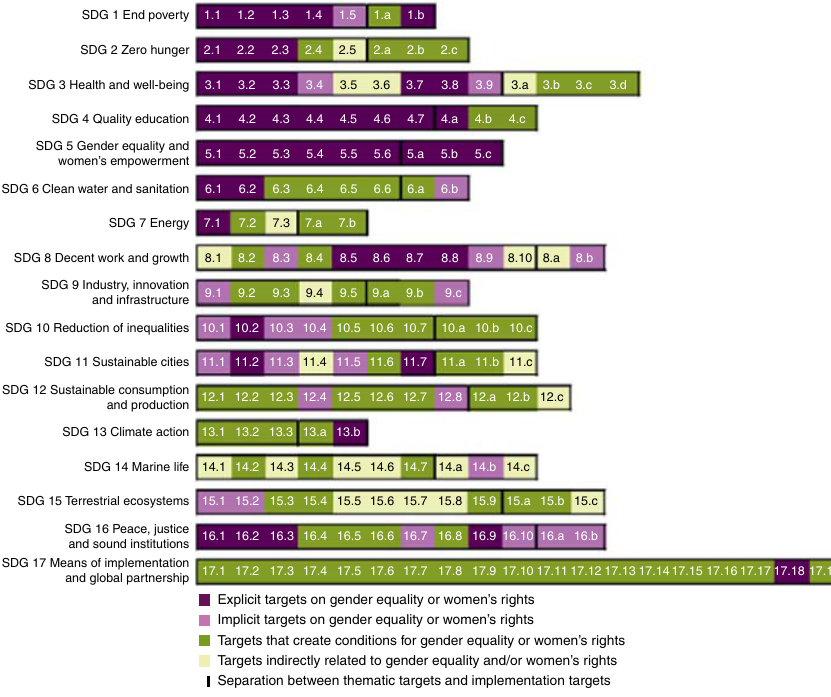
Separation between thematic targets and implementation targets